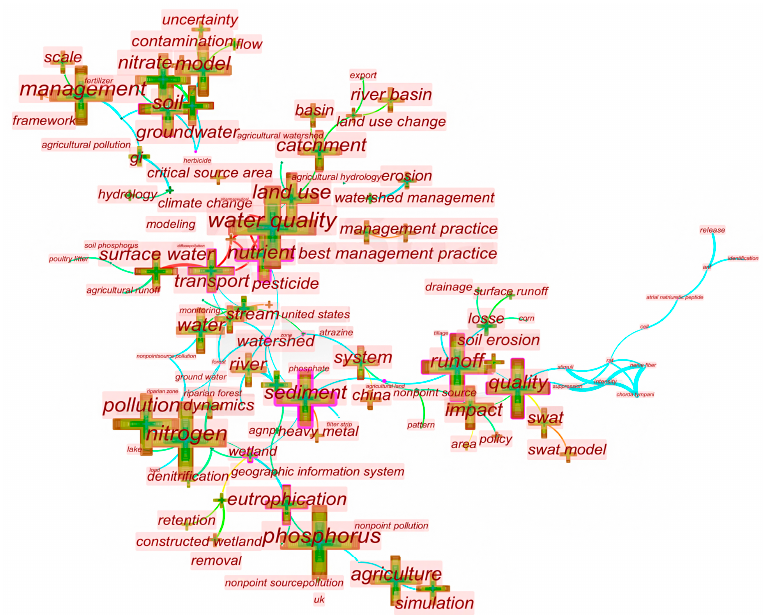
Figure 3. Co-occurring networks of keywords. Note: Nodes represent keywords. The size of nodes is proportional to the frequency of occurrence. The lines between nodes represent the co-occurrence relationship. The thicker the lines, the stronger the co-occurrence relationship.